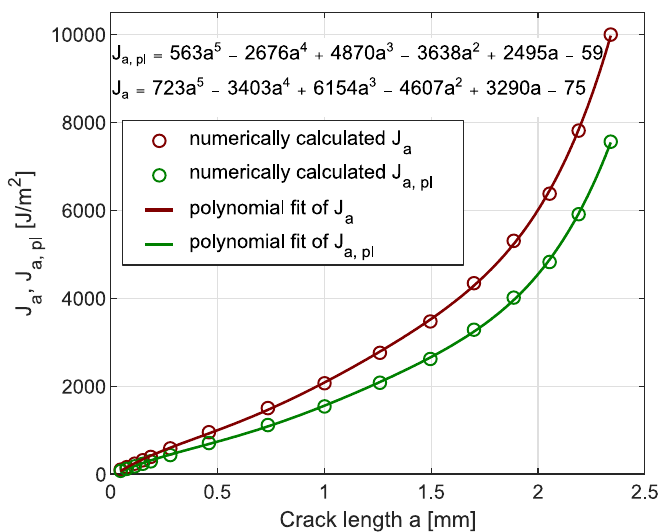
Figure 14. Amplitude of J-integral and amplitude of plastic part of J-integral vs. crack length a for 304L in the case of cyclic test at total strain amplitude ε a = 0.4%. The data is fitted by the polynomial function, which can be used for the calculation of J-integral (or the plastic part of J-integral) for any particular crack length within the interval from 0.1–2.4 mm.